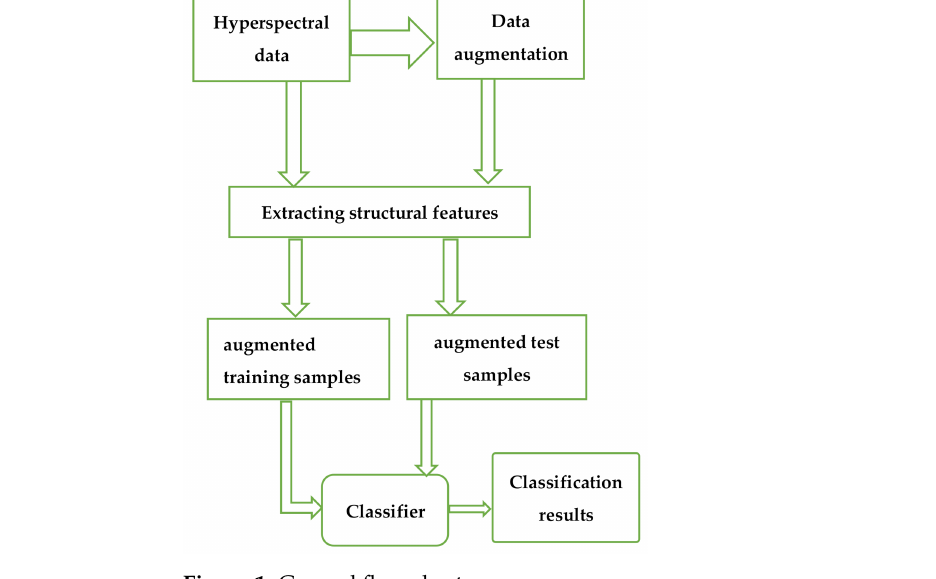
Figure 1. General flow